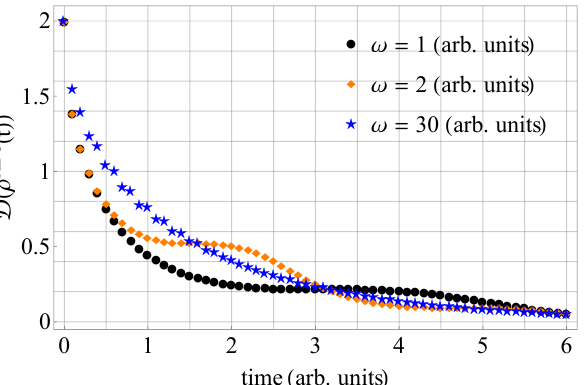
Figure 10. Plots present the Bures distance, D ( ρ ABC ( t )) , for three values of ω . Initially, the system was represented by the W